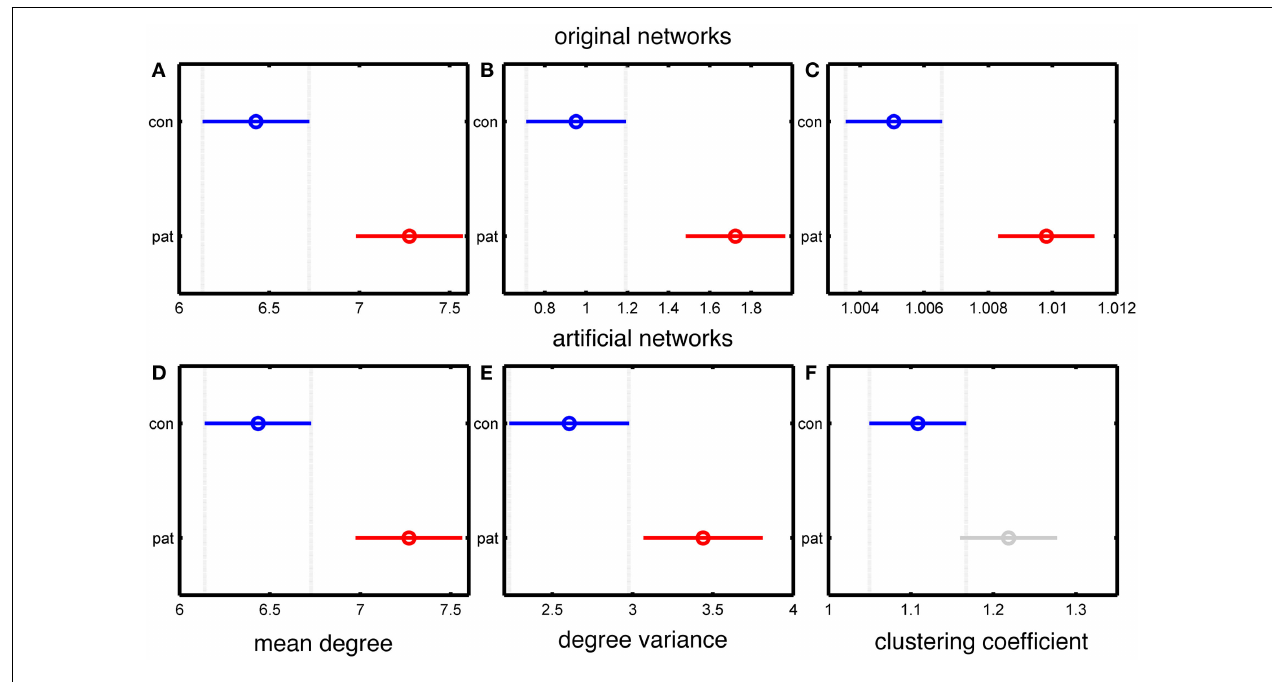
measure.The results are color coded blue for the control group and red for the epilepsy group (except for panel F , in which the epilepsy group is colored grey to indicate a lack of statistically significant difference).The horizontal line and the circle show the variance and the mean value of the corresponding network measure.The mean values are considered as statistically significant different if there is no overlap between the lines within a